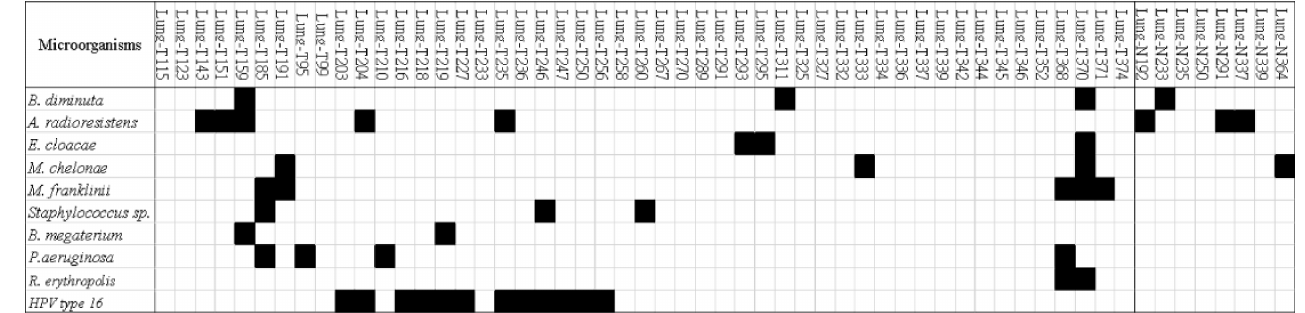
Figure 1. Microorganism composition of the lungs revealed by metatranscriptomic